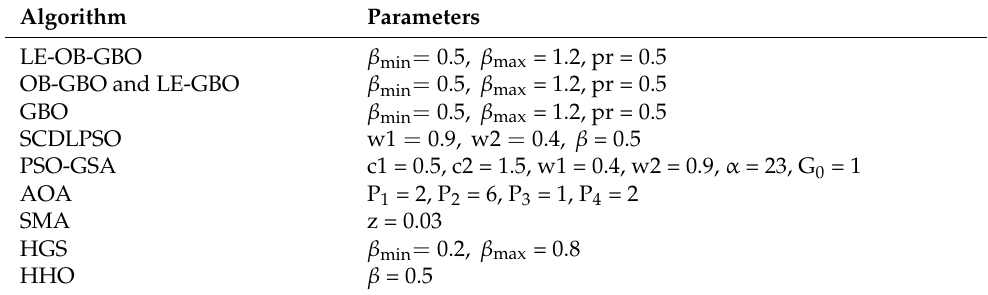
Table 2. Algorithm-specific parameters. Algorithm